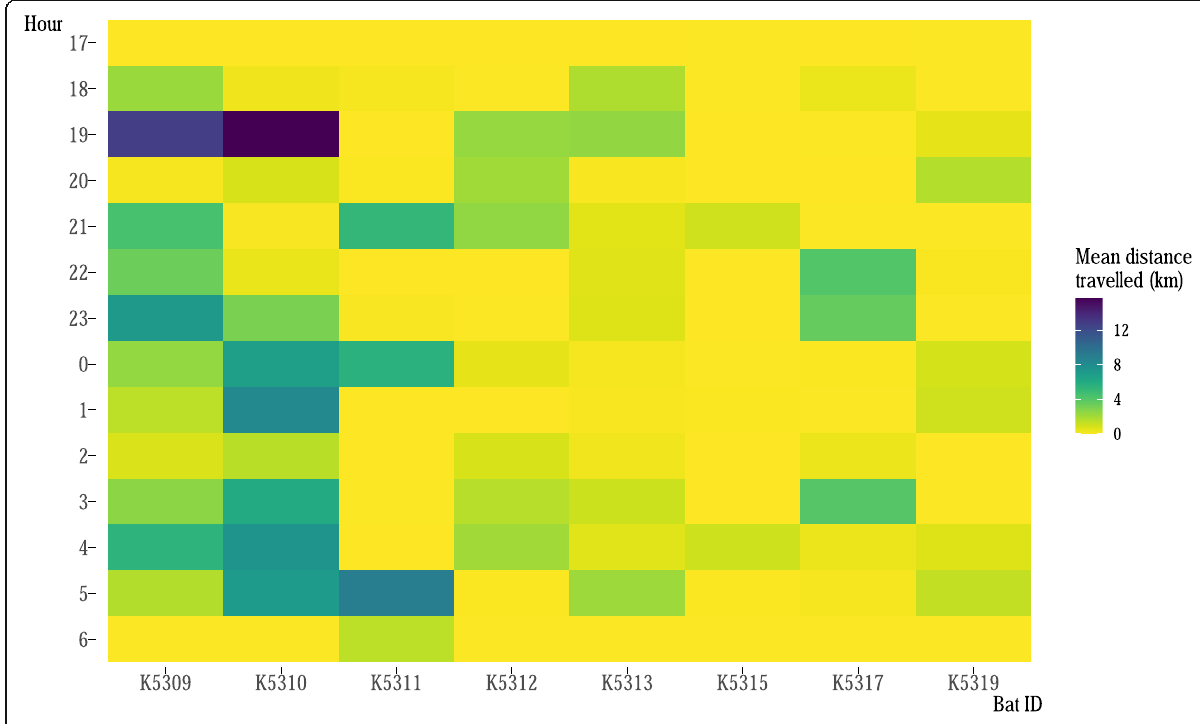
Fig. 5 Heatmap of the mean hourly distances (km) flown by individual bats on foraging